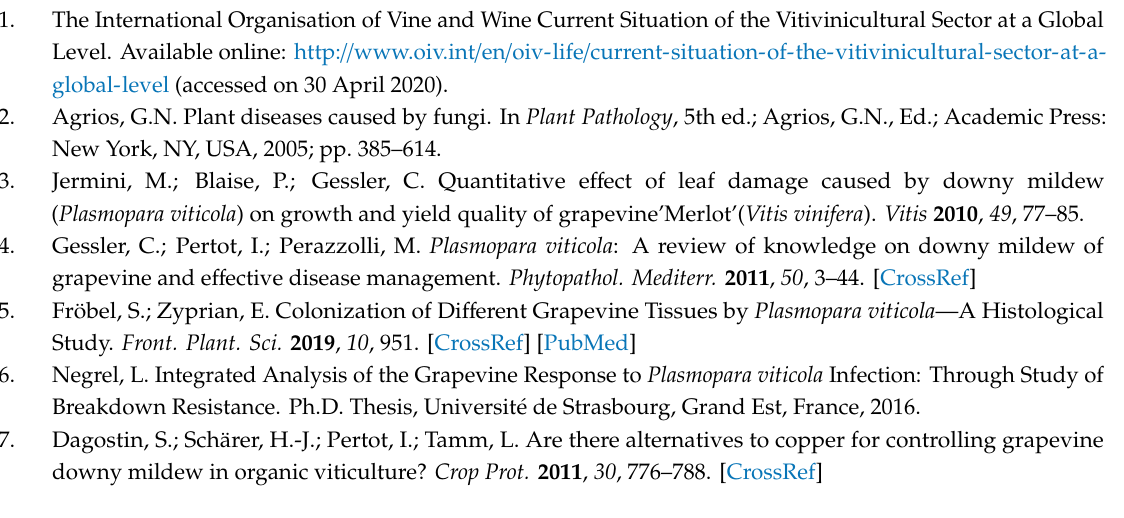
Table S1: Toxicological studies performed to assess the hazard of the active substance “Lysate of Willaertia magna C2c Maky” to human health; Table S2: Ecotoxicological studies performed to assess the hazard of the active substance “Lysate of Willaertia magna C2c Maky” to the